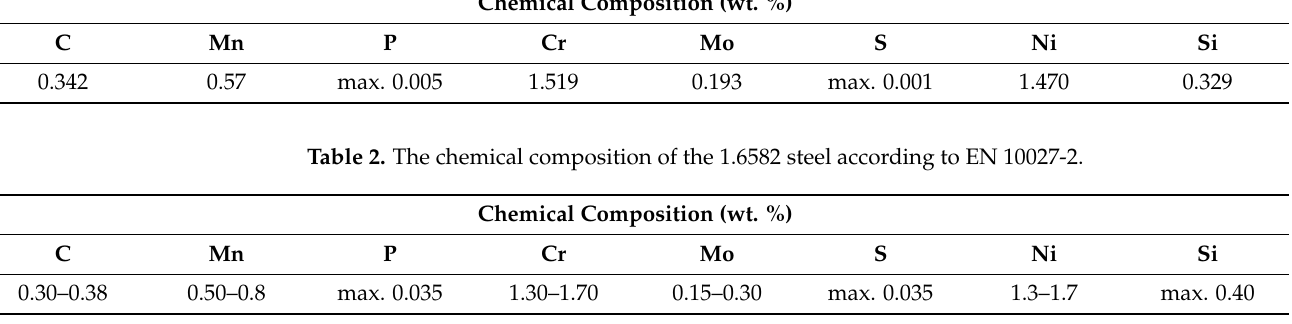
Table 1. The chemical composition of the 1.6582 steel according to measurements Q4 TASMAN. Chemical Composition (wt. %)